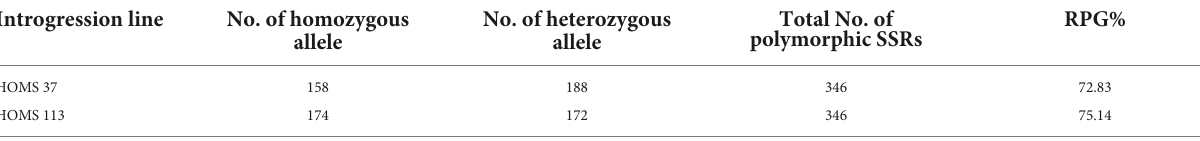
TABLE 7 Details of homozygous/heterozygous SSRs found in recurrent parent genome recovery analysis. Introgression line